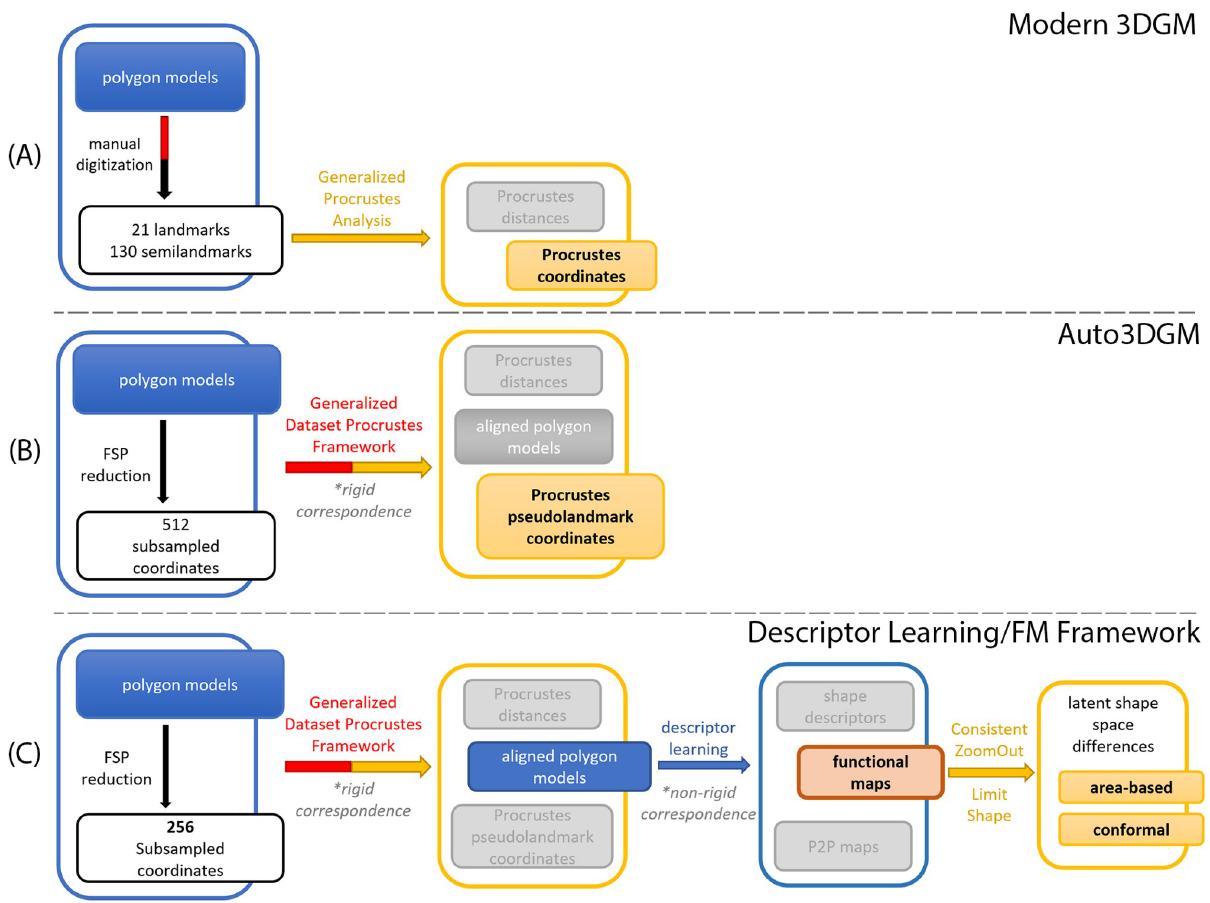
Fig 1. Dataflow graphs of shape analysis pipelines used. Rounded rectangular objects represent data objects and arrows depict the procedures/ algorithms operating on or producing them. All three analyses begin with triangular mesh models of bone. In (A) , triangular mesh models are manually digitized. The configurations of corresponding/homologous points obtained are subjected to Generalized Procrustes analysis (GPA) to yield Procrustes pseudolandmark coordinate shape variables. (B) represents automated quantification using Auto3DGM. Farthest point sampling (FSP) is used to subsample triangular meshes. The Generalized Dataset Procrustes Framework (GDPF) of auto3DGM assigns correspondences and aligns subsampled shapes to a common coordinate system (rigid alignment). (C) outlines the proposed descriptor learning approach that builds on auto3DGM with learned non-rigid/deformable functional correspondences between aligned polygon models. These functional maps are used to estimate latent shape space differences that characterize morphological variation expressed as area-based and conformal operators. Note that the GDPF step here subsamples shape at a low resolution with only 128 and 256 pseudolandmarks for initial and final alignment steps, respectively. While not sufficient for capturing shape variation, low-resolution auto3DGM produces the rotation and translation information needed to rigidly align our polygon models.